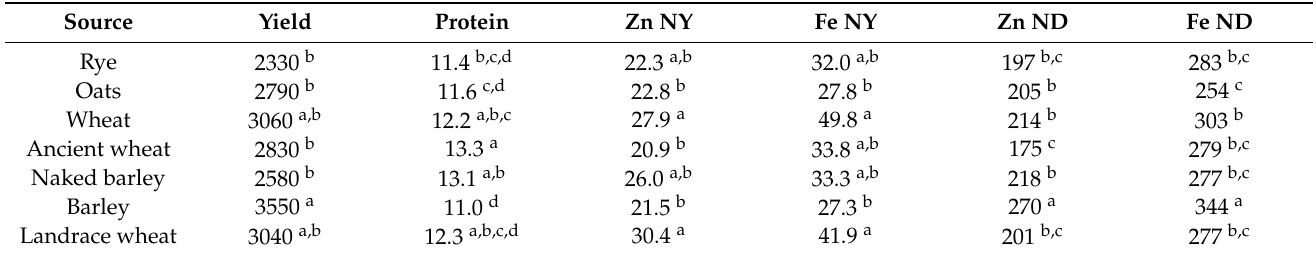
Table 7. Means of total yield (kg ha − 1 ), protein content (%), Fe and Zn nutritional yield (NY; adults/ha/year) and nutrient density (ND; amount in g needed to be consumed to achieve 100% of the daily recommended intake) of spring cereal groups cultivated in four different locations over three